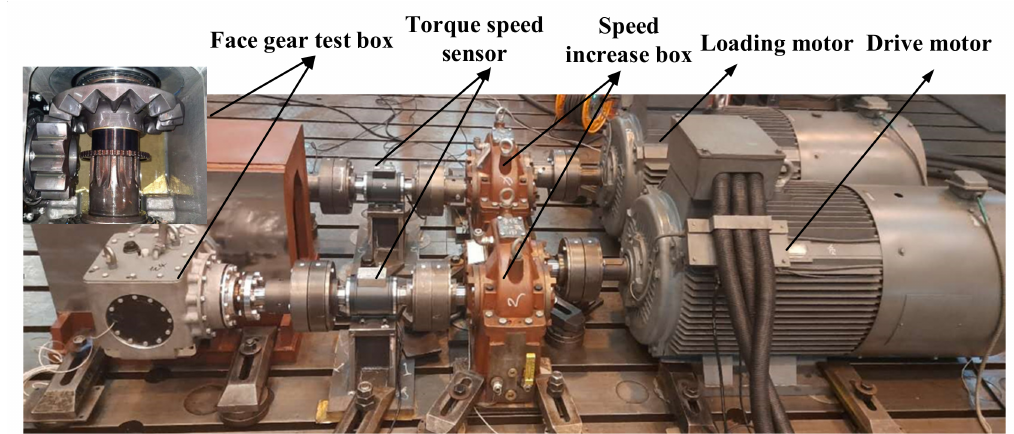
Figure 14. Gearbox test